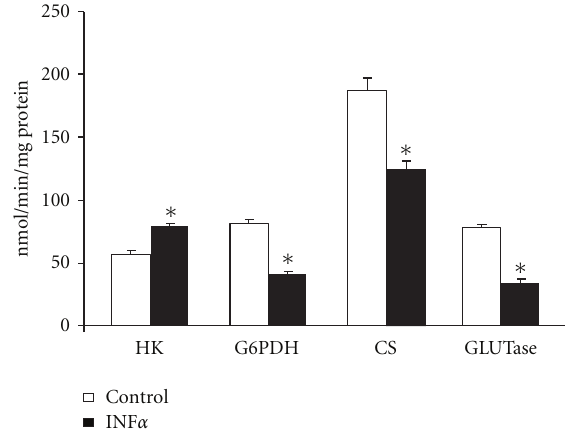
Figure 1: Maximal activity of enzymes of mesenteric lymphocytes cultured in the presence or absence of IFN α . The results are expressed as nmol/min per mg of protein and represent the mean ± SEM of 9 experiments. HK: hexokinase; G6PDH: glucose-6- phosphate dehydrogenase; CS: citrate synthase; GLUTase: phos- phate dependent glutaminase. ∗ P < . 05 for comparison with the control (C) group.